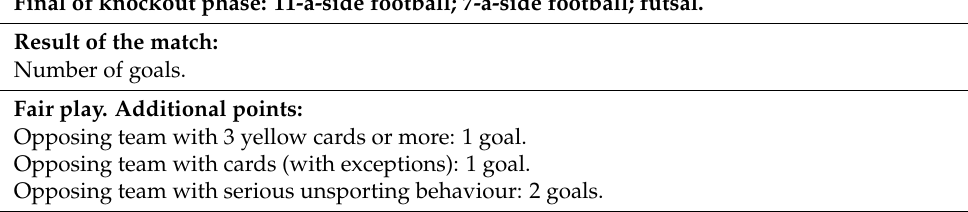
Table 2. Rules in final of knockout